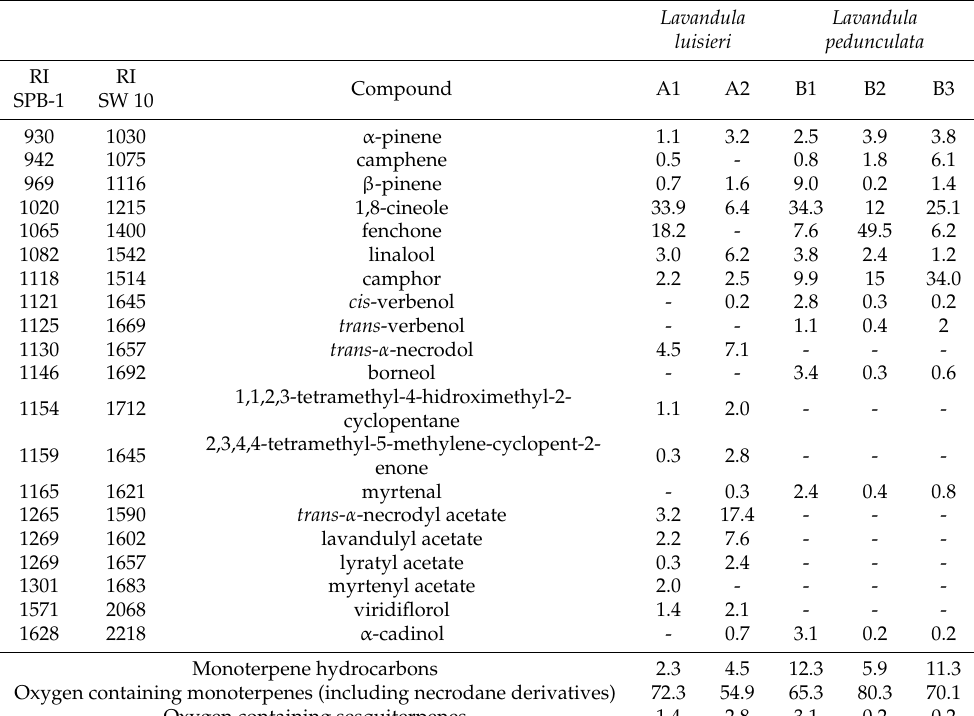
Table 1. Main compounds of Lavandula luisieri and Lavandula pedunculata essential